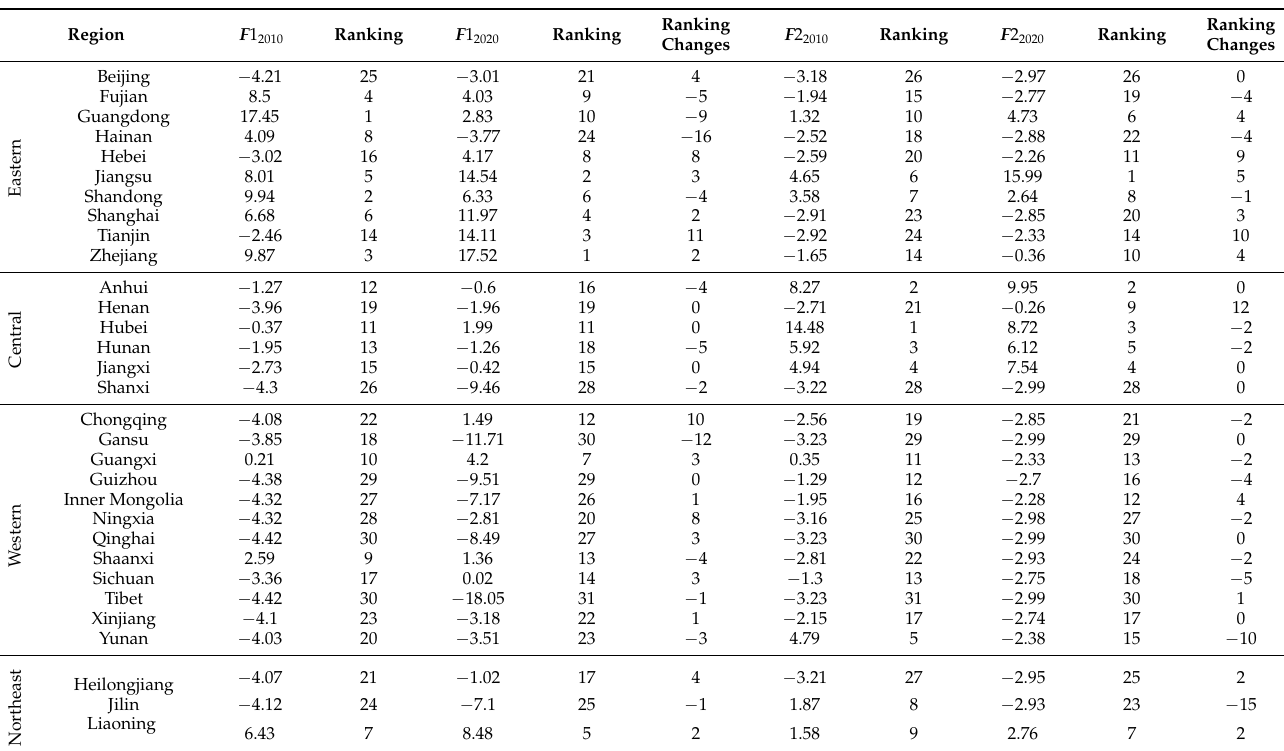
Table 2. Changes in the comprehensive environmental and income evaluations of China’s regions. Source: Authors’ own calculations based on data from the China Fisheries Statistical Yearbook 2011 and China Fisheries Statistical Yearbook